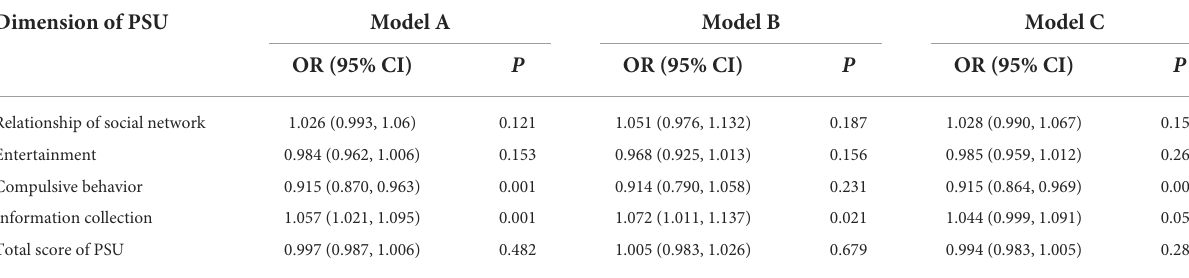
TABLE 4 Associations between PSU and blood pressure abnormality by multivariable logistic regression